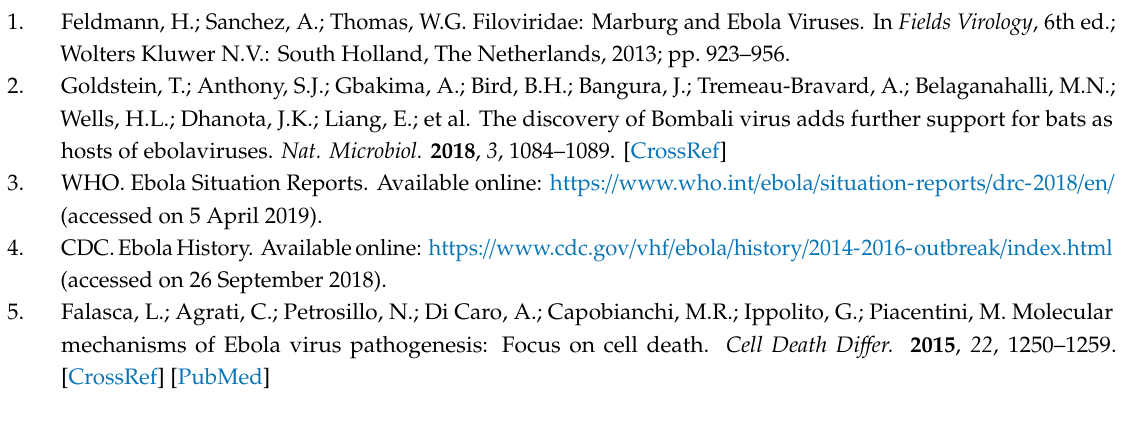
Table S1: Characteristics of EVD patients, Table S2. Fold-changes in the pathway-focused gene expression of the single secreted proteins, Table S3. Kinetics of the anti-EBOV antibodies response and viremia in EVD fatal and survived